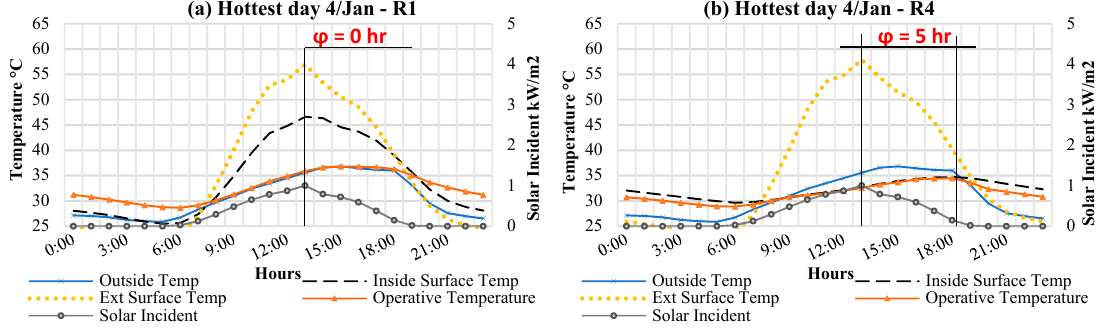
Figure 7. Surface temperatures for the roof in the original state R1 ( a ) and for the solution R4 ( b ).